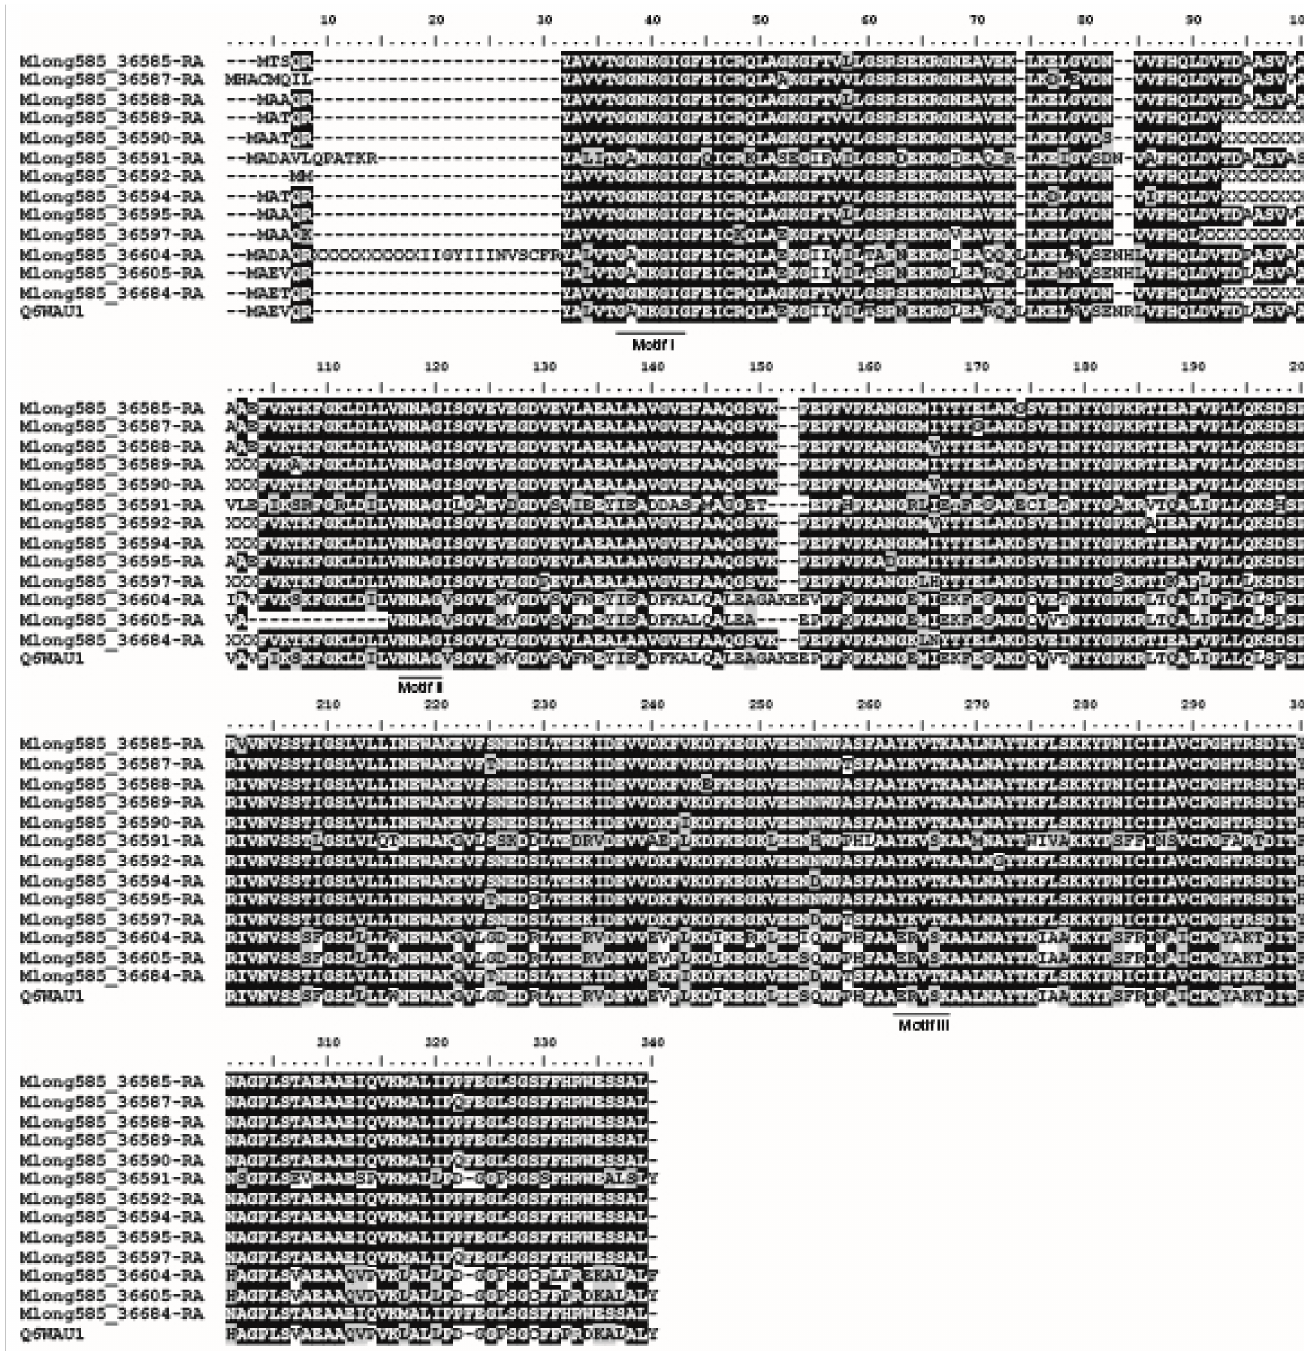
Figure 5. Alignment of 13 M. longifolia isopiperitenone reductase amino acid sequences with the canonical sequence (QSWAU1) from peppermint [12]. X characters indicate ambiguous nucleotides in the M. longifolia reference genome. Conserved coenzyme motif (Motif I), NNAG site (Motif II), and active site motif (Motif 3) are